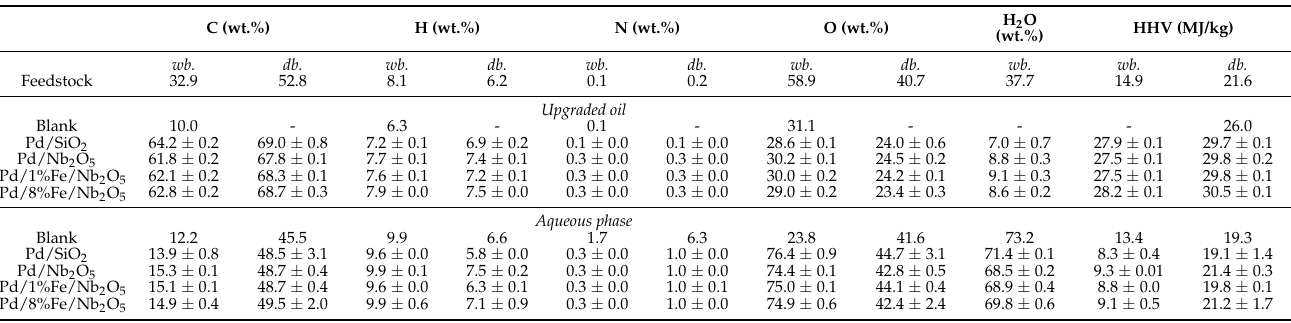
Table 1. Elemental composition, water content and high heating value (HHV) of the feedstock and the liquid upgraded